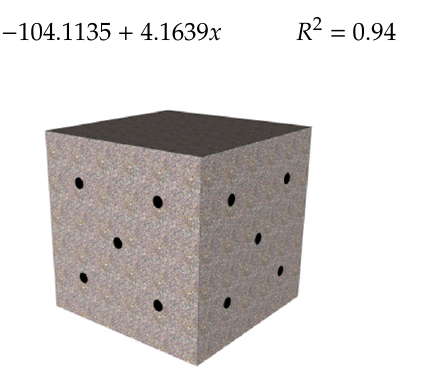
Figure 15. Measuring points.